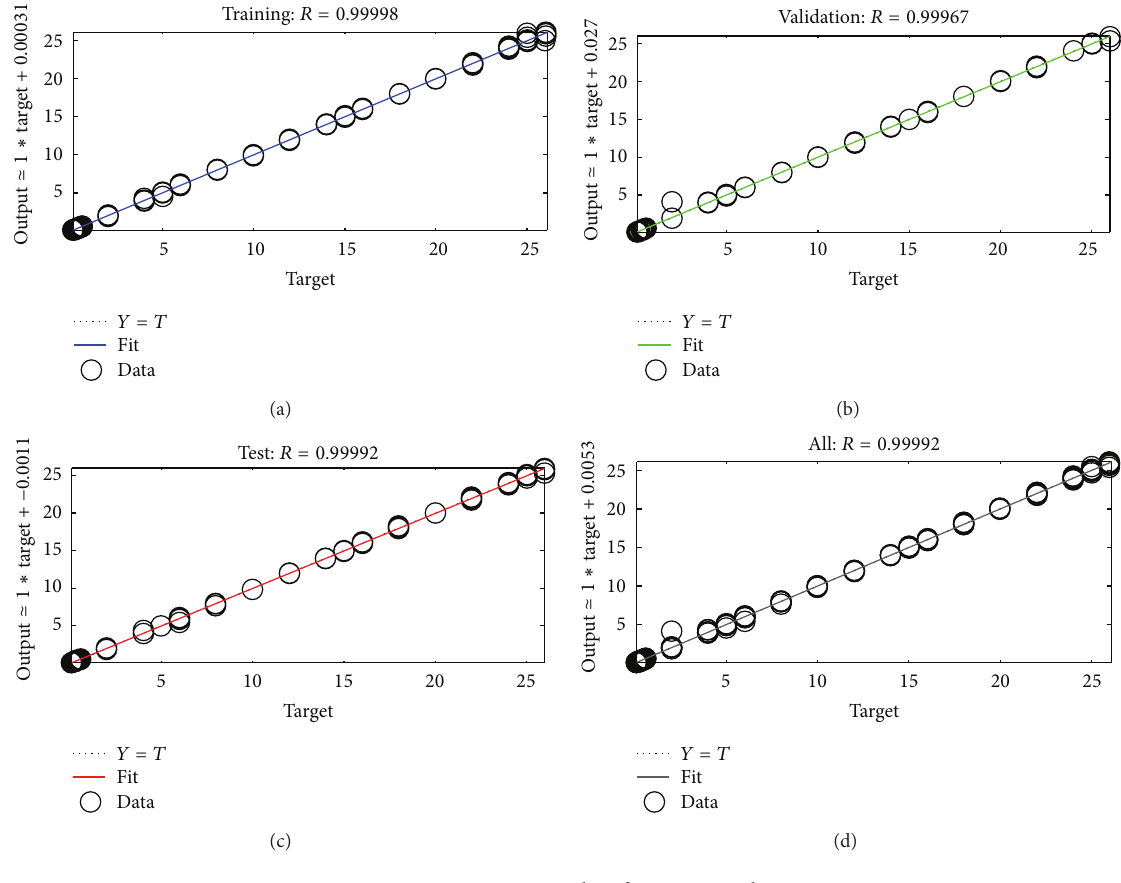
Figure 12: Regression plot of FFBP